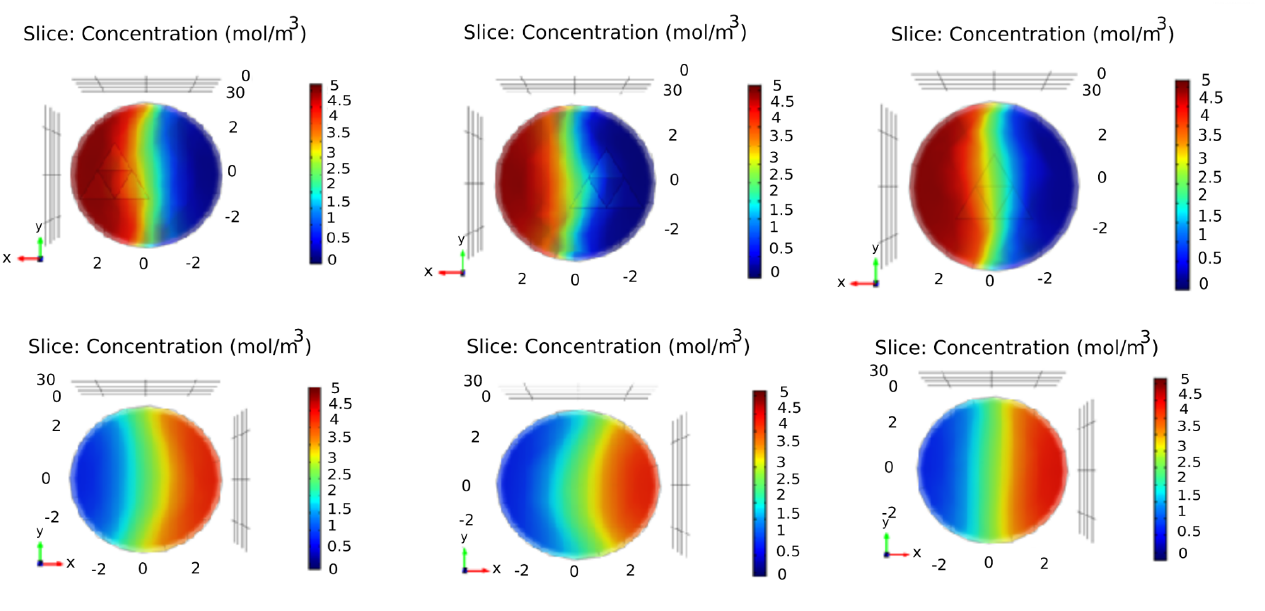
Figure 9. Sierpinski triangle object in center area in the first iteration for input (front up view-right), and for output (rear down view-right), Sierpinski triangle in low concentration area in the first iteration for input (front up view-center), and for output (front down view-center), and Sierpinski triangle object in high concentration area in the first iteration for input (front up view-left), and for output (rear down